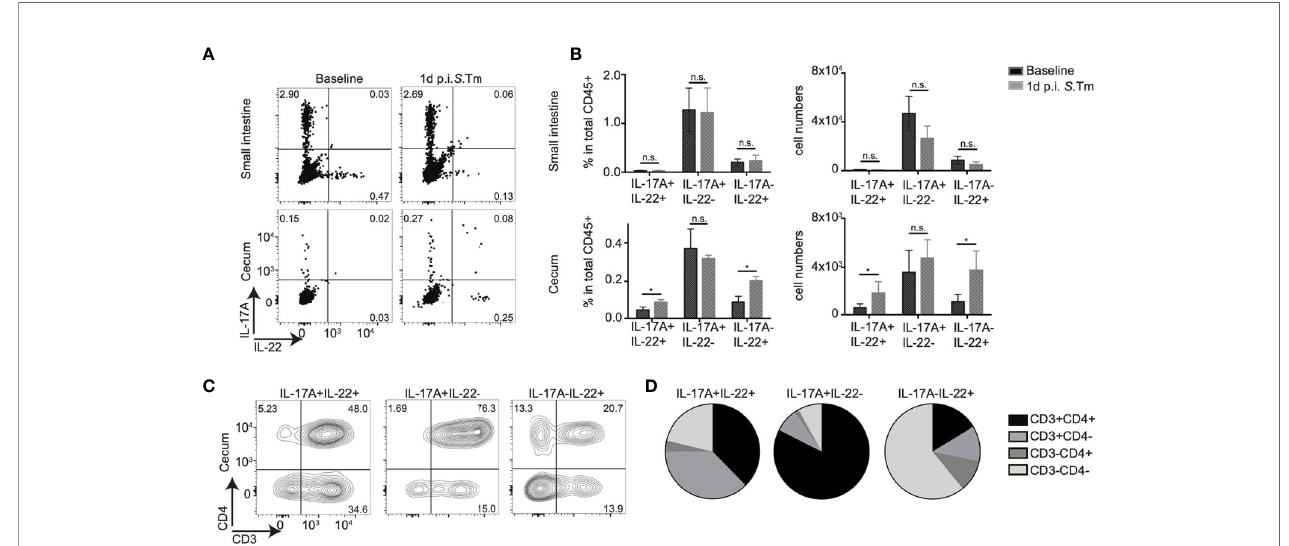
FIGURE 1 | CD4+ T cells contribute to mucosal IL-17A and IL-22 secretion upon bacterial infection. (A – D) IL-17A GFP IL-22 BFP Foxp3 RFP (conventionally raised) mice were infected orally with 10 5 CFU of Salmonella enteria serovar Typhimurium ( S . Tm. ) after streptomycin-pretreatment. Lamina propria leukocytes (LPL) were isolated from the small intestine and cecum of uninfected (baseline) and 1 day post S . Tm. infected mice. Isolated LPL were analyzed by FACS without any ex vivo restimulation. (A) Representative FACS plots show IL-17A and IL-22 frequencies gated on total CD45+ cells. In (B) frequencies within CD45+, LPL and total numbers of cytokine- producing cells are shown. (C) Representative FACS plots analyzing CD3 and CD4 expression gated on IL-17A and/or IL-22 producing cells and relative frequencies of indicated cell subsets within CD45+ cells (D) . Data represent n = 4 – 10 mice/group as mean ± SEM from at least two independent experiments. P-values indicated represent an unpaired Student ’ s t test *p < 0,05; n.s., not signi fi cant. See also Supplementary Figure S1